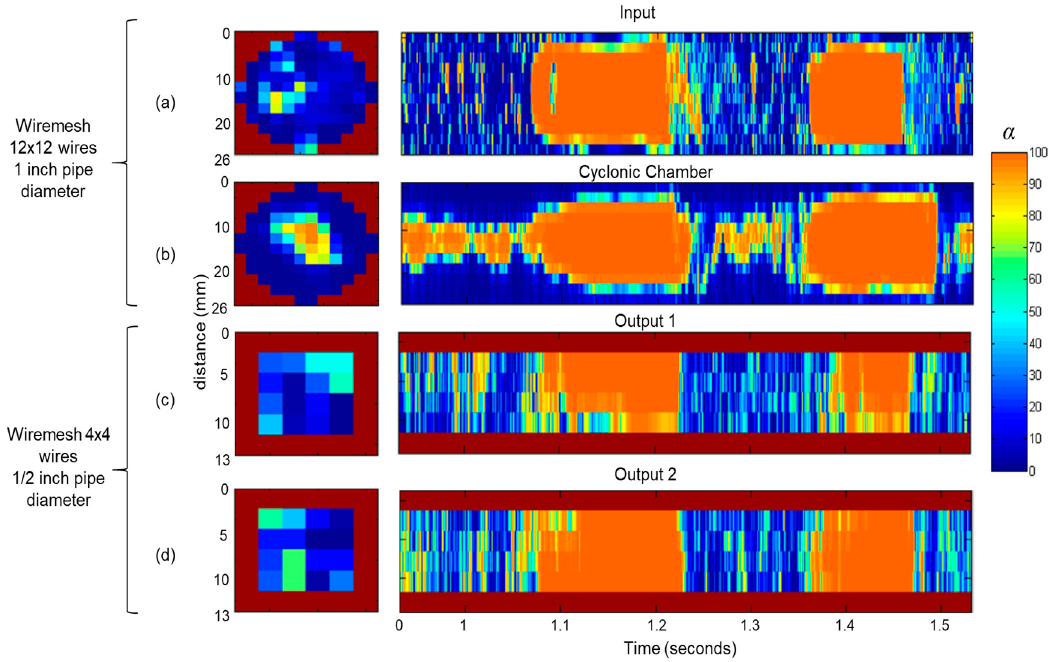
Figure 8. Axial and longitudinal view of void fraction using the WMS in two-phase flow with J L = 1.0 m/s and J G = 1.0 m/s. ( a ) Input, ( b ) cyclonic chamber, ( c ) outlet 1 and ( d ) outlet 2.